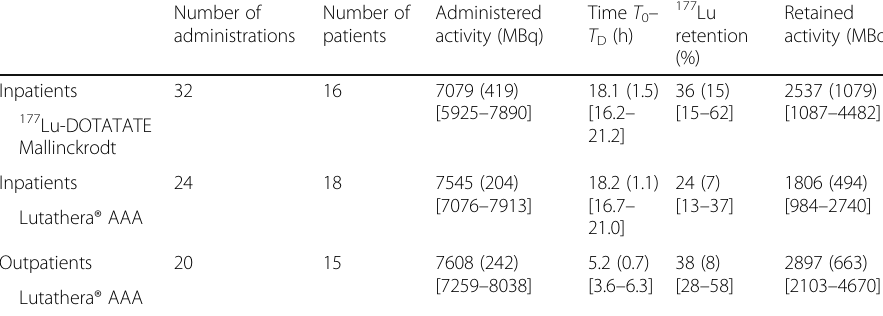
Table 1 Mean (SD) [range] administered activity, length of stay in hospital, percentage 177 Lu and activity retention at discharge for outpatient and inpatient administrations Number of